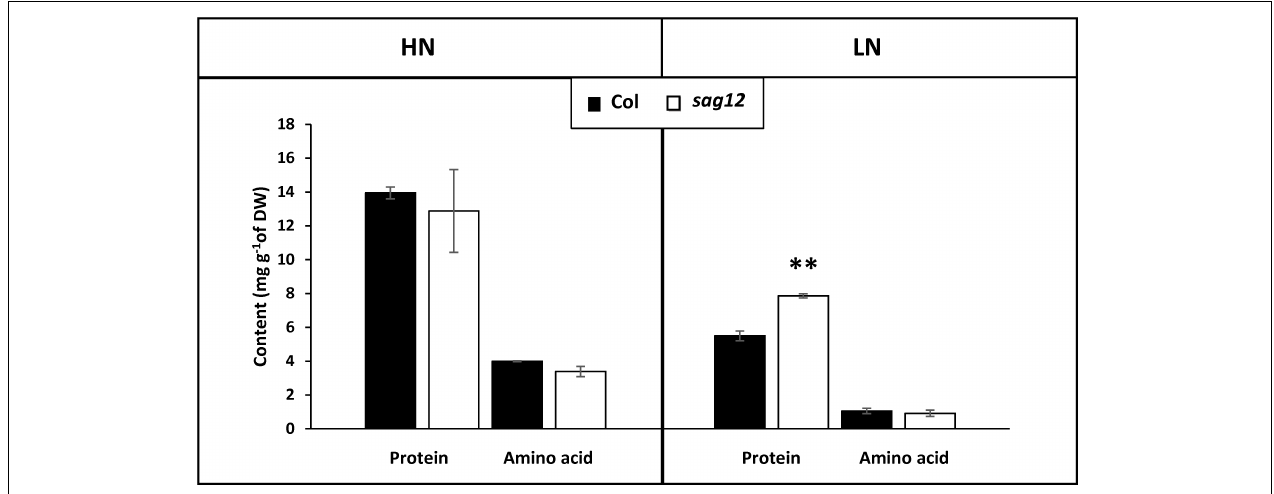
FIGURE 4 | Protein content is higher in roots of sag12 at the reproductive stage. The roots of Col (black bars) and sag12 (white bars) plants cultivated under high (HN) and low (LN) nitrogen conditions were harvested at the reproductive stage (85 DAS). Values are means ± SE, n = 4. Significant difference between Col and sag12 ( ∗∗ p ≤ 0.01; n = 4).